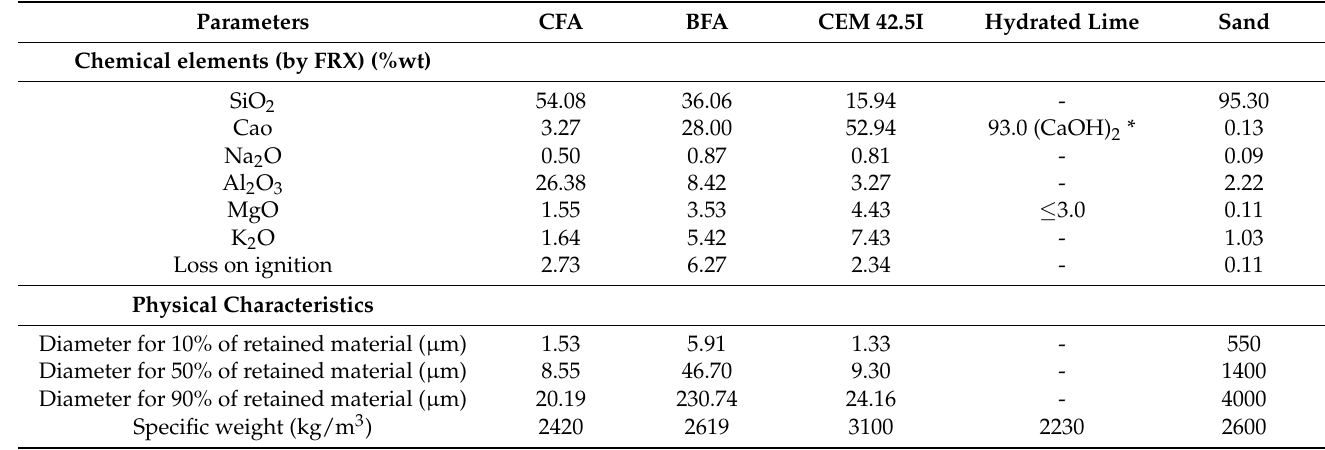
Table 1. Chemical and physical characteristics of used